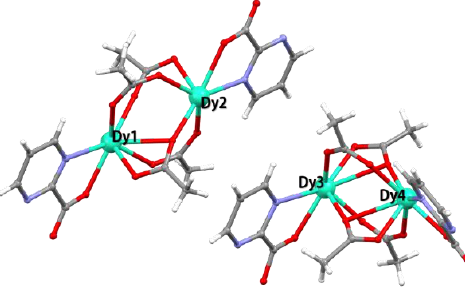
Figure 1. View of the asymmetric unit of compound 1 .